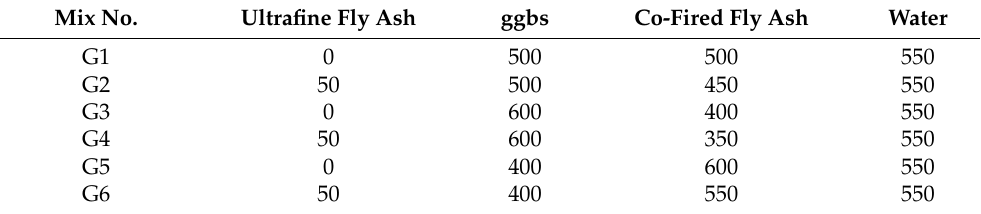
Table 2. Mix proportions (unit: